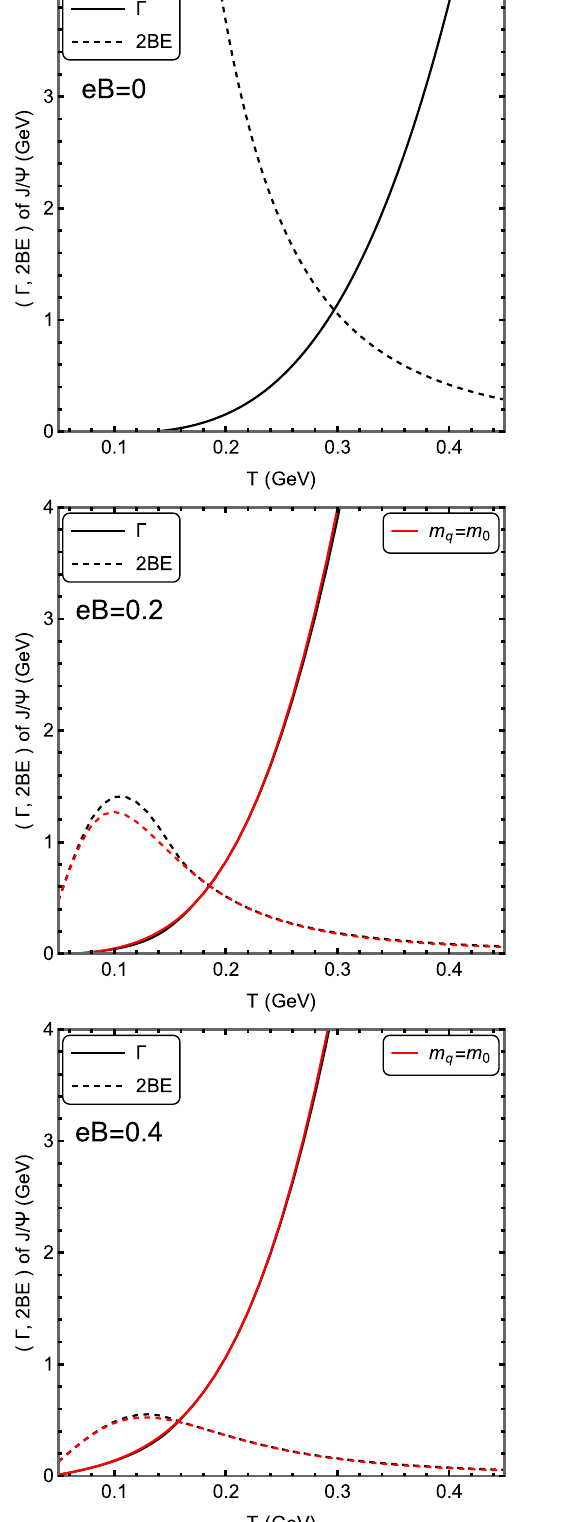
Fig. 8 Variation of (cid:15) , 2BE with temperature with different values of magnetic field (eB) for